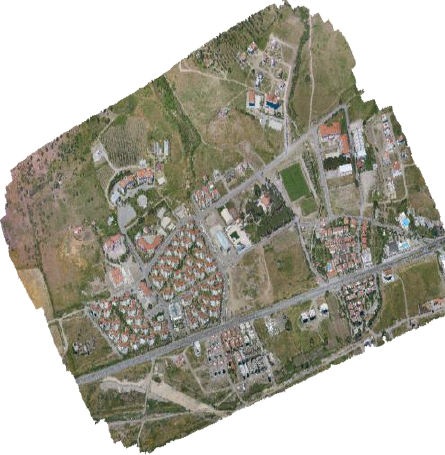
Figure 2. Image based point cloud (30461747)